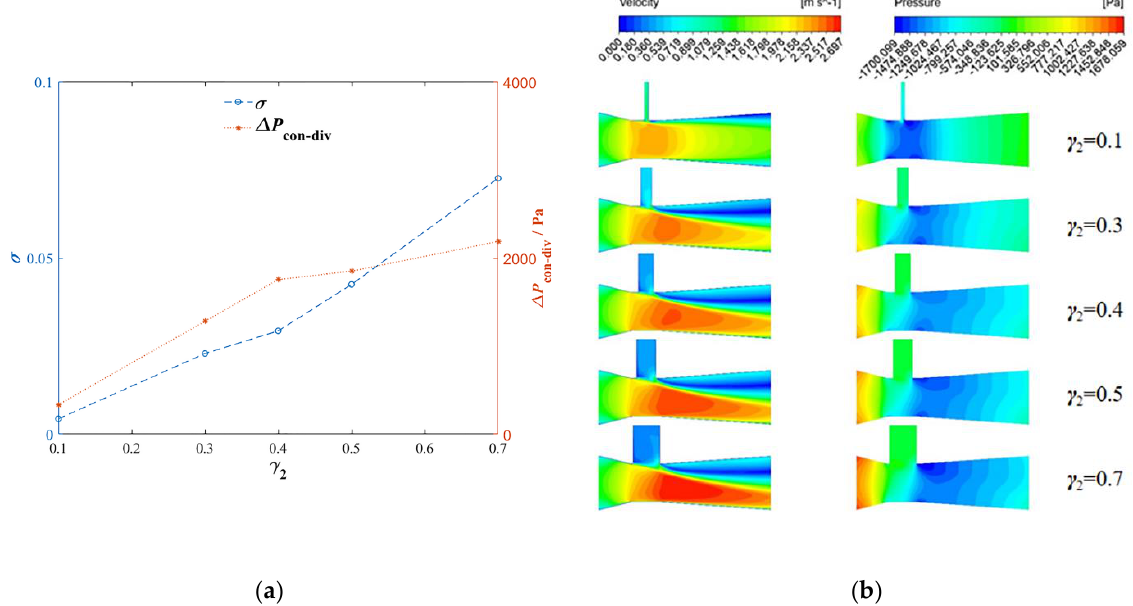
Figure 10. The effects of pore-throat diameter ratio on ( a ) ∆ P con-div and σ ( b ) velocity and pressure distributions in VTM. distributions in